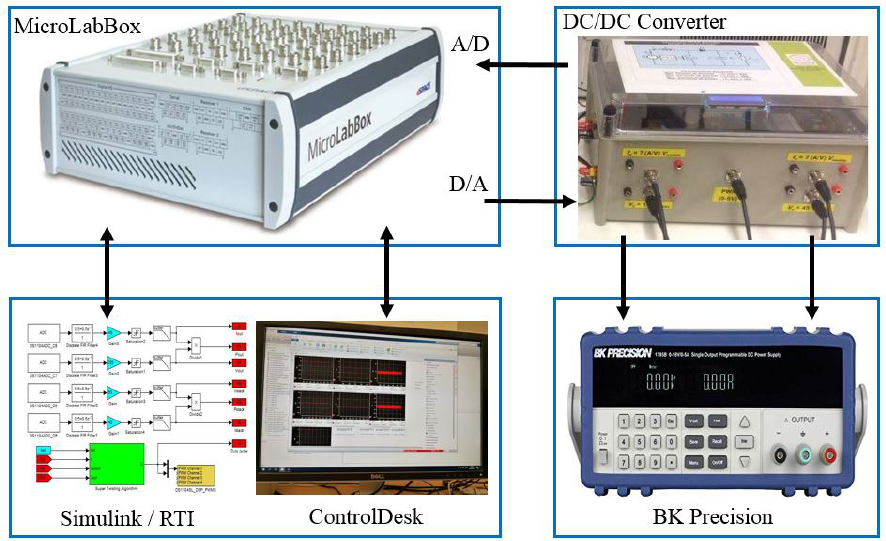
Figure 13. System